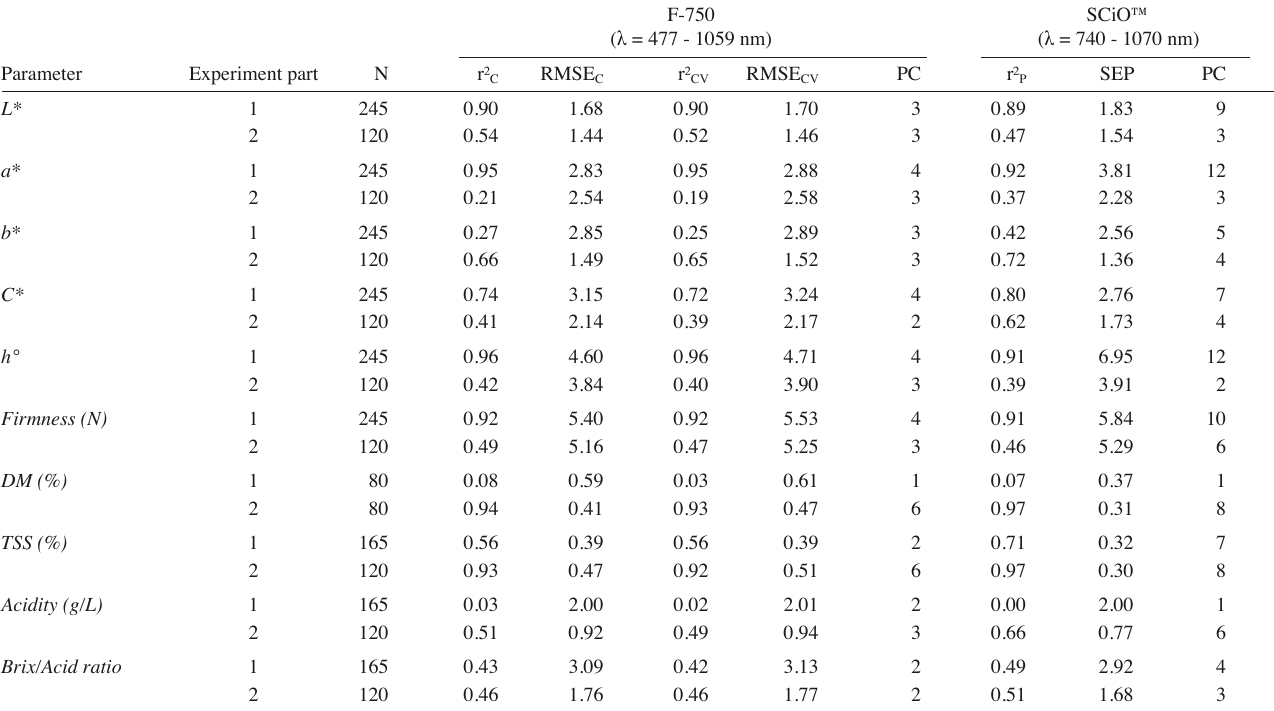
Tab. 3: Prediction of tomato quality parameters of the F-750 Produce Quality Meter and SCiO™ Molecular Sensor using the respective manufacturer’s soft - ware. L*, a*, b*, C*, h°: colorimetric values; TSS: total soluble solids; r² C : r² of calibration; RMSE C : root mean square error of calibration; r² CV : r² of cross-validation; RMSE CV : root mean square error of cross validation; PC: principal